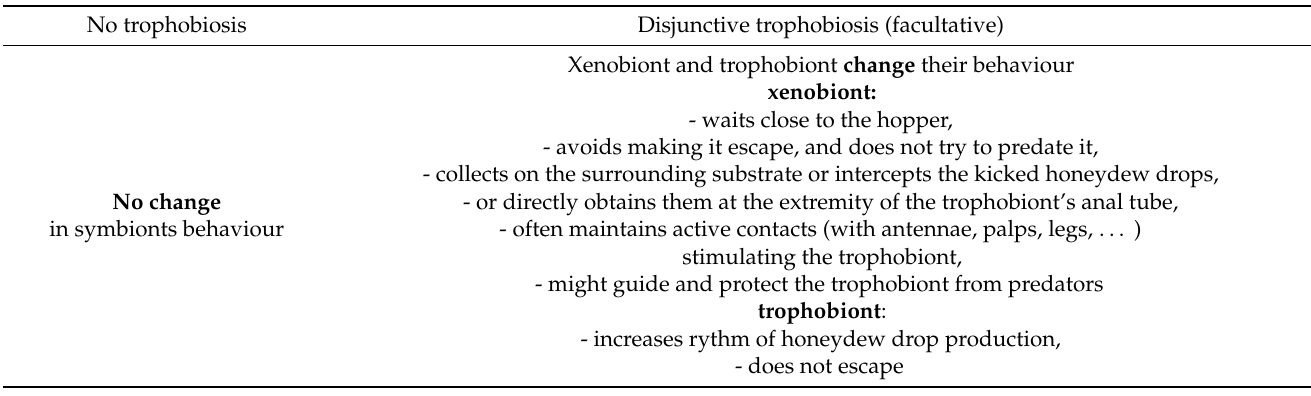
Table 2. Different types of trophobiosis behaviours observed with Fulgoromorpha